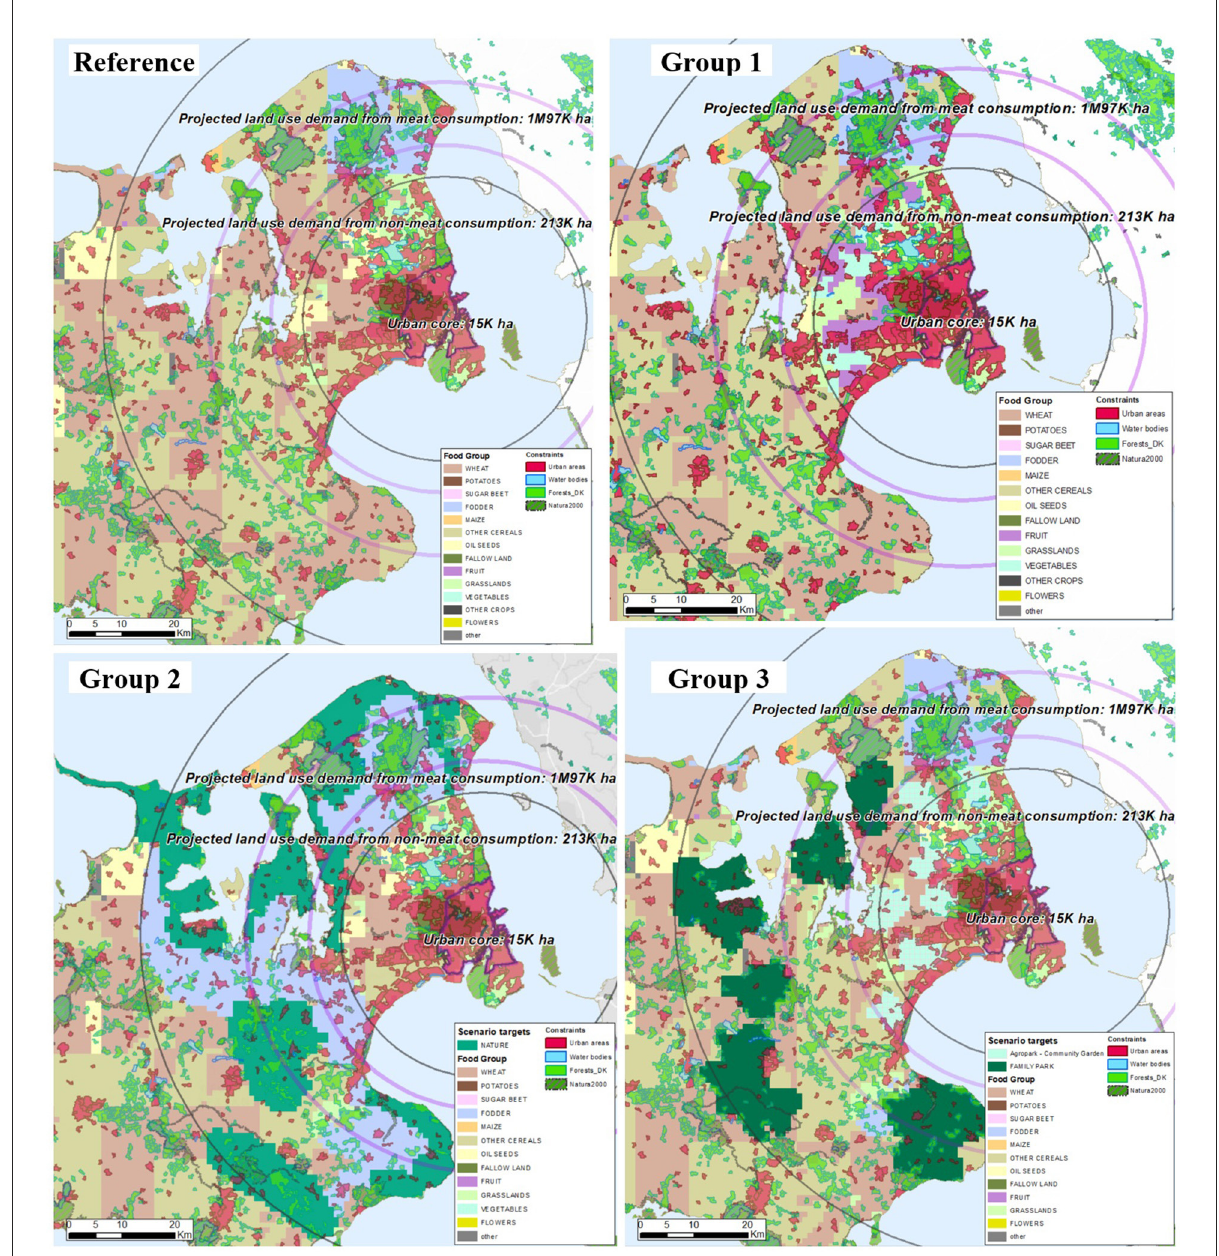
FIGURE10 Reference situation and results from three groups as applied to Copenhagen on the MapTable. Black circles represent the land footprint of current consumption (outer: animal-based, inner: plant-based), while the purple circles represent the land footprint of the EAT-Lancet scenario.